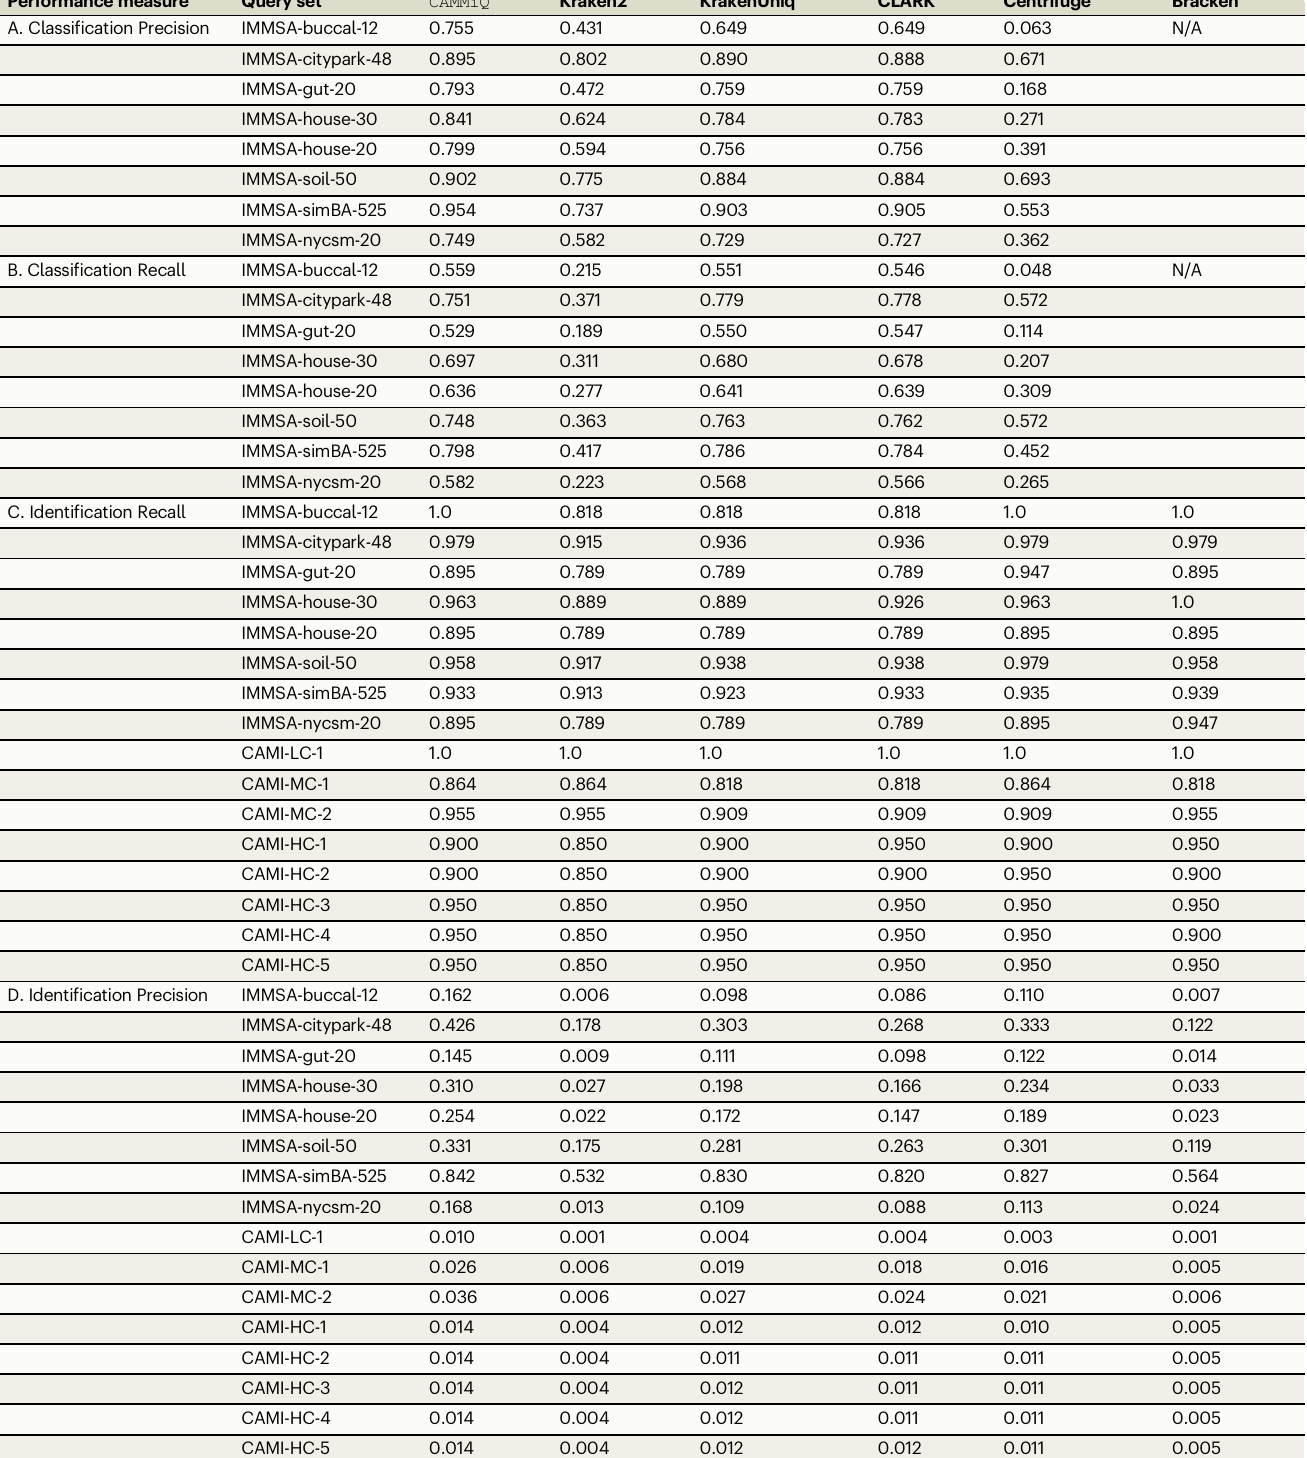
Table 2 | Performance evaluation of CAMMiQ , Kraken2, KrakenUniq, CLARK, Centrifuge, and Bracken on CAMI and IMMSA benchmark queries against the species-level-all index